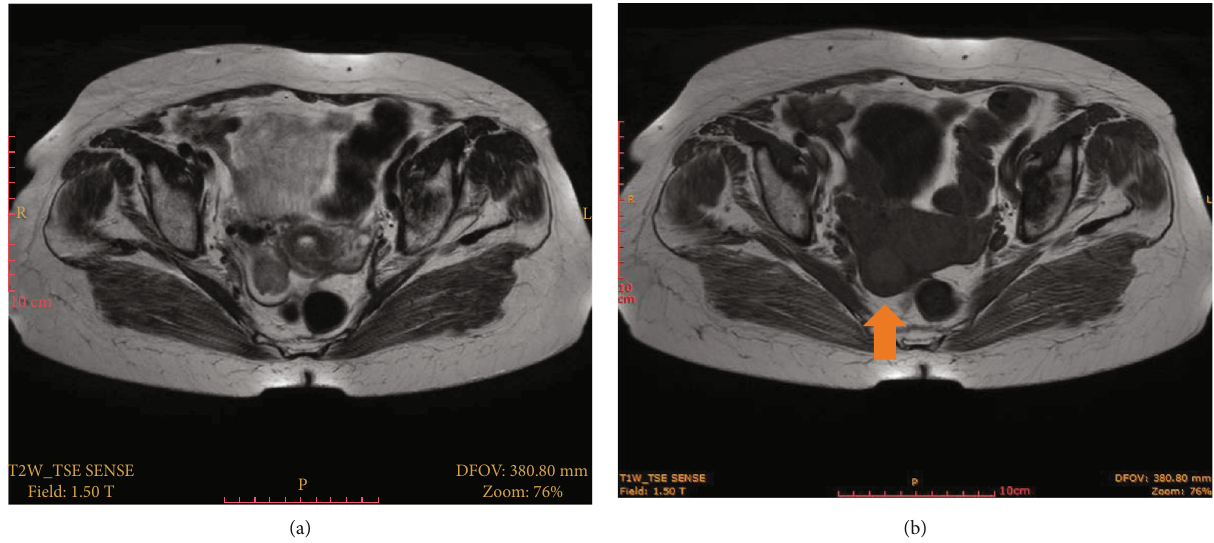
Figure 1: (a) Transaxial T2-weighted MRI shows a right adnexal mass (arrow) displaying thick wall with high signal intensity. (b) Loss of signal on T1-weighted image.